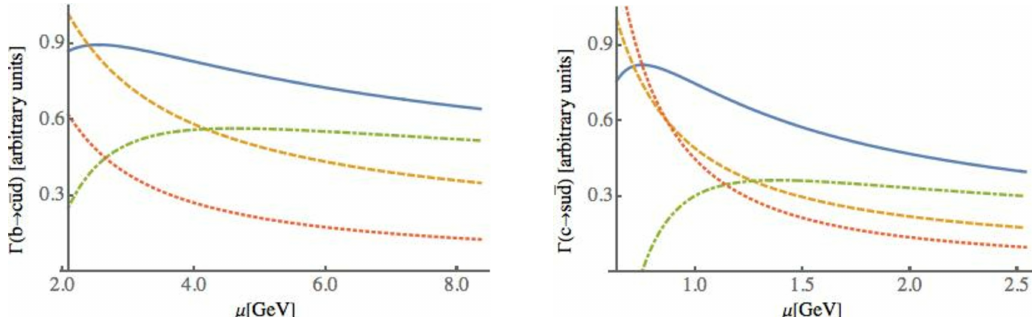
Figure 1 . Scale dependence of Γ( b → cud ) (left panel) and Γ( c → sud ) (right panel) in the MS scheme. The solid-blue and dashed-orange lines show the result of the NLO and LO calculations, respectively. The line in dot-dashed-green shows the LO calculation to which the term with the explicit factor of α s ln( µ ) in the NLO decay rate is added, displaying cancellation of scale dependence to order α s . The dotted-red line shows the difference between the blue and green lines, that is, the NLO decay rate sans the term with an explicit factor of ln( µ )